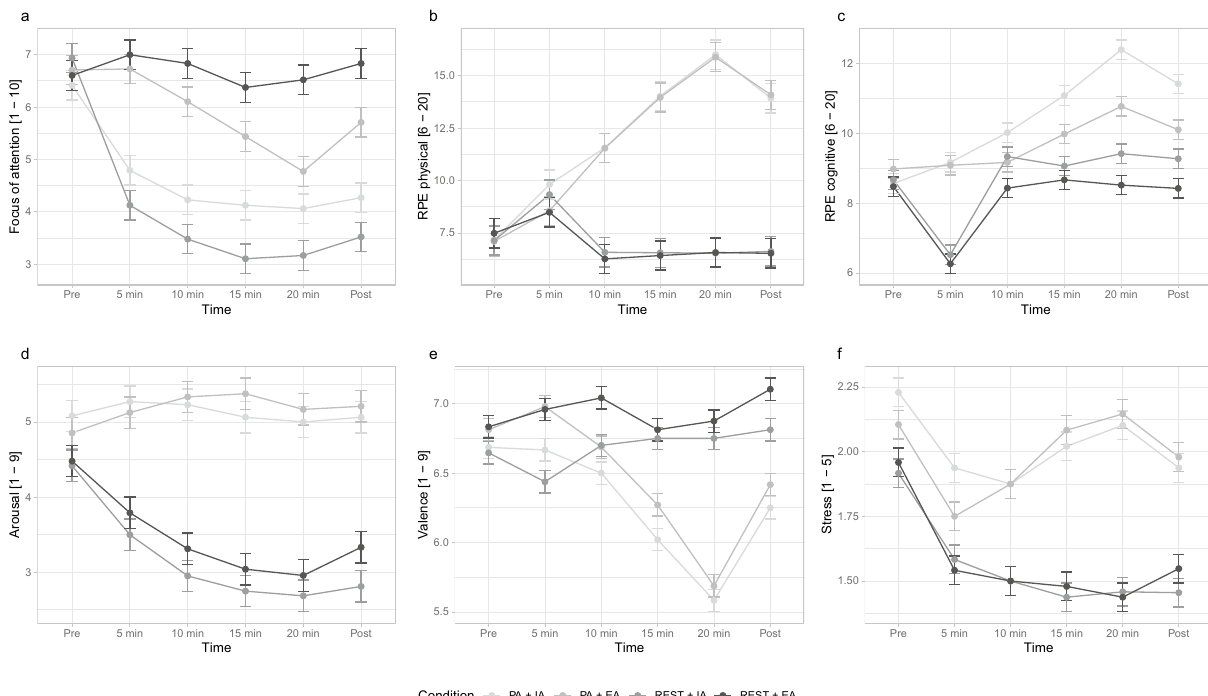
Figure 2. Line graphs depicting the affective and perceptual responses to each condition, recorded before (pre), during (5, 10, 15, 20 min), and after (post) the manipulation. ( a ) Focus of attention; measured using a VAS scale with lower scores indicating internal focus, and higher scores indicating external focus. ( b ) RPE physical; measured using the Borg scale, with higher numbers indicative of increased physical strain. ( c ) RPE cognitive; measured using an adapted Borg scale, with higher number indicative of increased cognitive strain. ( d ) Arousal; measured using the Self-Assessment Manikin, with higher scores indicative of increased arousal. ( e ) Valence; measured using the Self-Assessment Manikin, with higher scores indicating positive valence, and lower scores indicating negative valence. ( f ) Stress; as measured using a VAS scale, with higher scores indicating higher states of acute stress. Error bars shown standard error, and scales are displayed on the